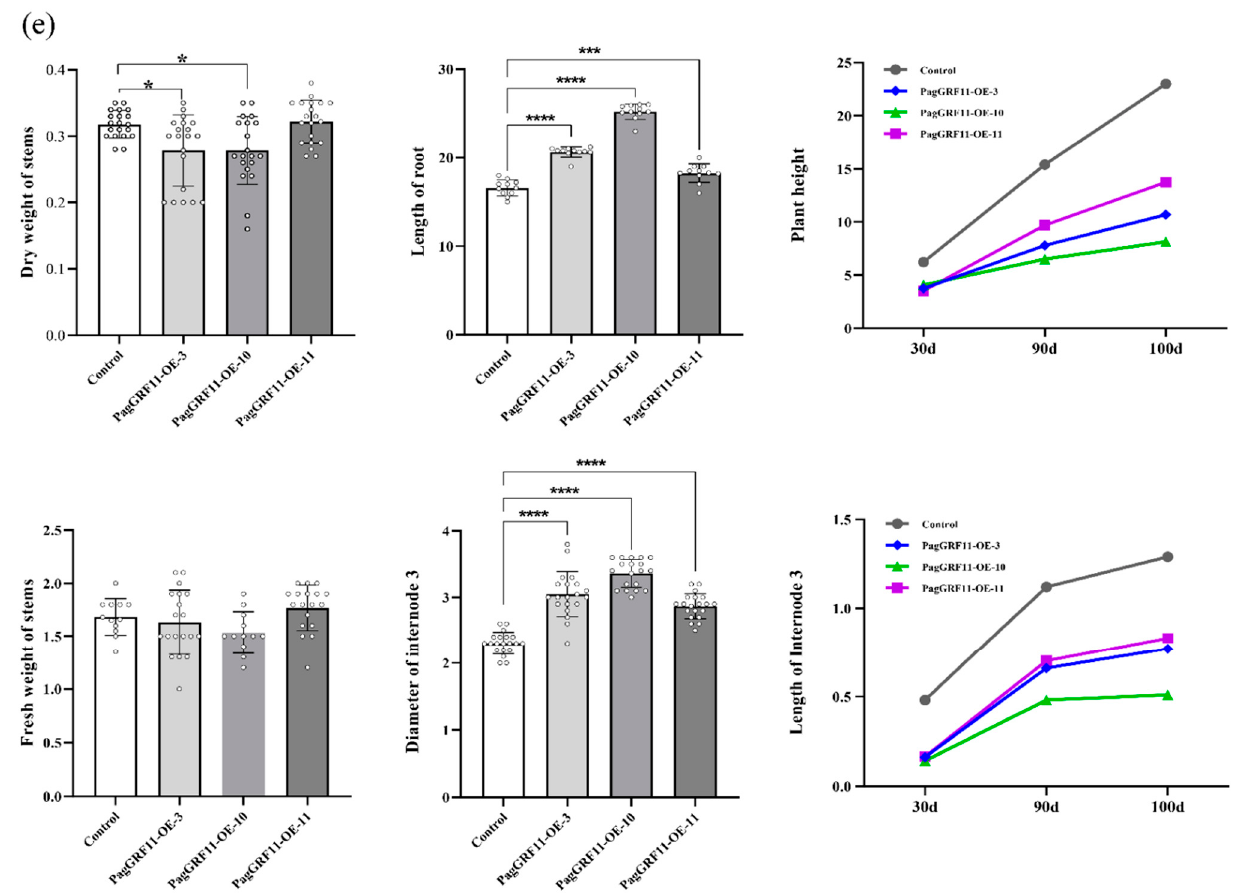
Figure 2. Morphological characterization of Pag-GRF11 -overexpressing transgenic plants. ( a – d ) General characteristics of 3-month-old plants overexpressing PagGRF11 and control. Control: “84K” populus carried the pBI121 empty vector (scale bar = 5 cm). ( a ) Plant height, ( b ) leaf, ( c ) root, and ( d ) stem internode of control and PagGRF11 transgenic plants. ( e ) Three-month-old plants were used to measure stem dry weight, stem fresh weight, plant height, third internode diameter, root length, stem third internode length. * denotes p < 0.0194, *** denotes p < 0.0002, **** denotes p <